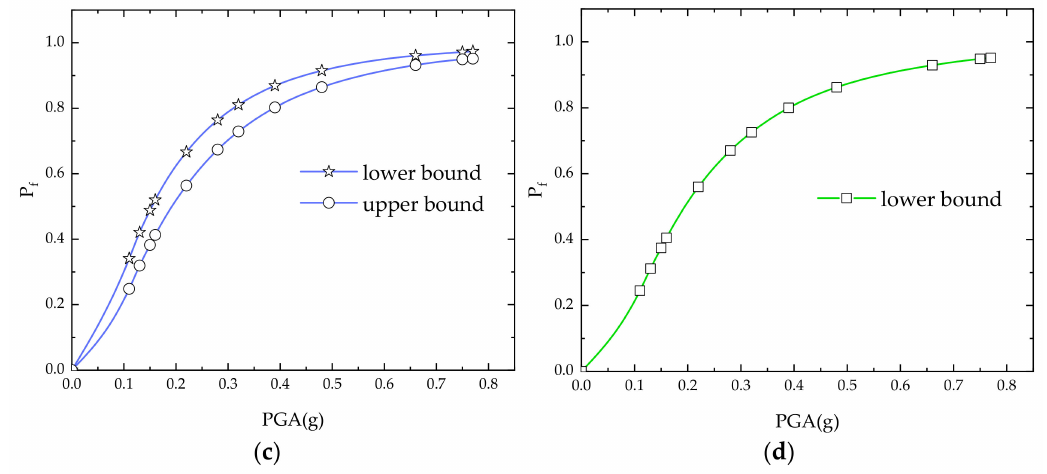
Figure 10. Fragility curves of aqueducts: ( a ) slight damage; ( b ) moderate damage; ( c ) extensive damage; ( d ) complete damage.